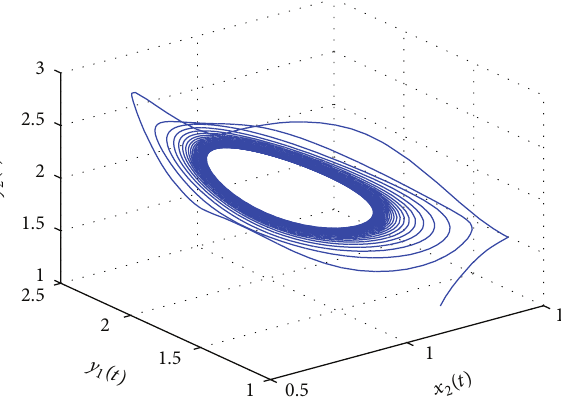
Figure 23: The phase plot of the states 𝑥 1 , 𝑥 2 , 𝑦 2 for 𝜏 2 = 7.5000 > = 6.6494 and 𝜏 ∗ = 2.5000 . 𝜏 ∗ 2 1